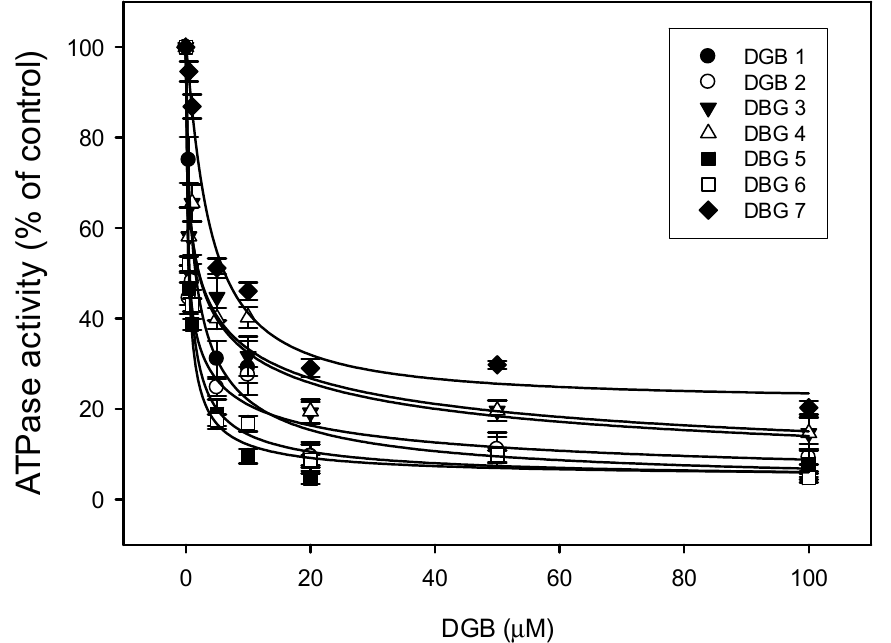
Figure 5. Effects of compounds on ATPase activity: Purified membranes enriched with Pdr5p were incubated in the presence of serial concentrations of digoxin derivatives, and the inorganic phosphate released was measured by the Fiske–Subbarow method. Data refer to three independent experiments. DGB 1-7: digoxin derivatives.